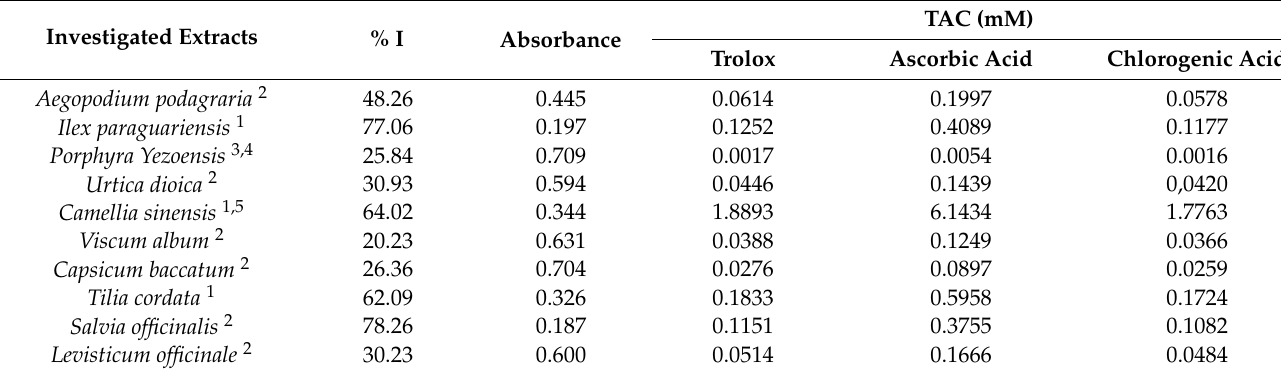
Table 4. The values of the equivalents of the reference substances, i.e., Trolox, ascorbic acid, and chlorogenic acid, for the tested extracts, calculated on the basis of calibration graphs made by the DPPH